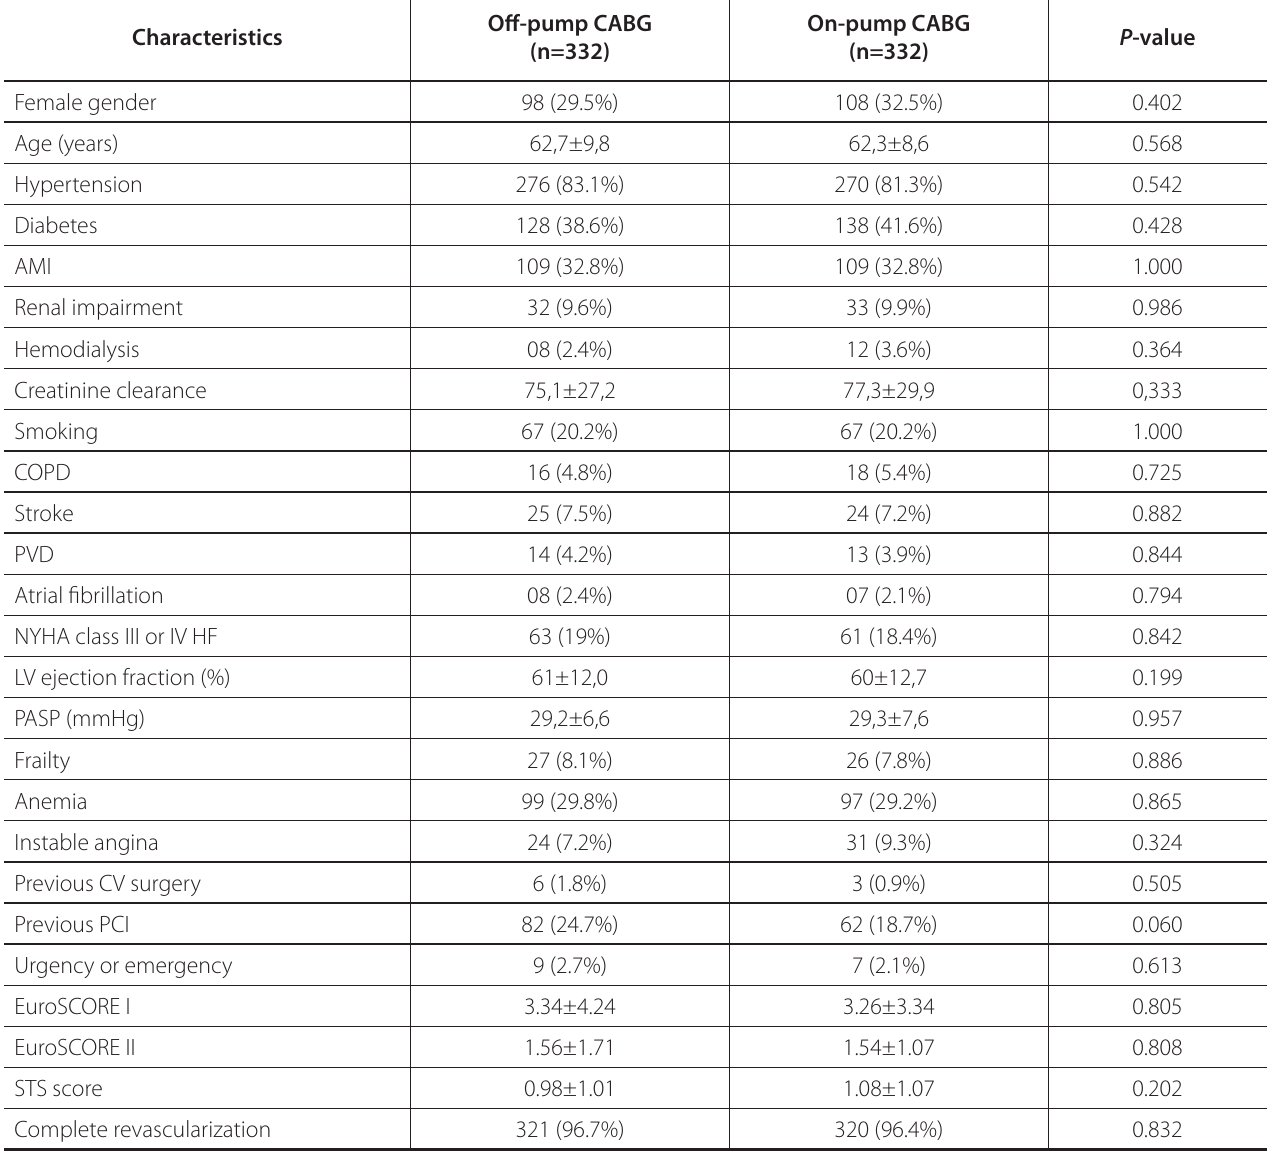
Table 1 . Baseline characteristics stratified by CPB